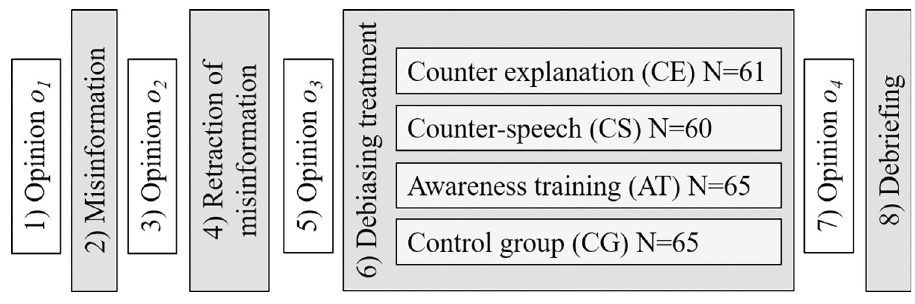
Fig 1. The study’s procedure with sample sizes for the debiasing treatment